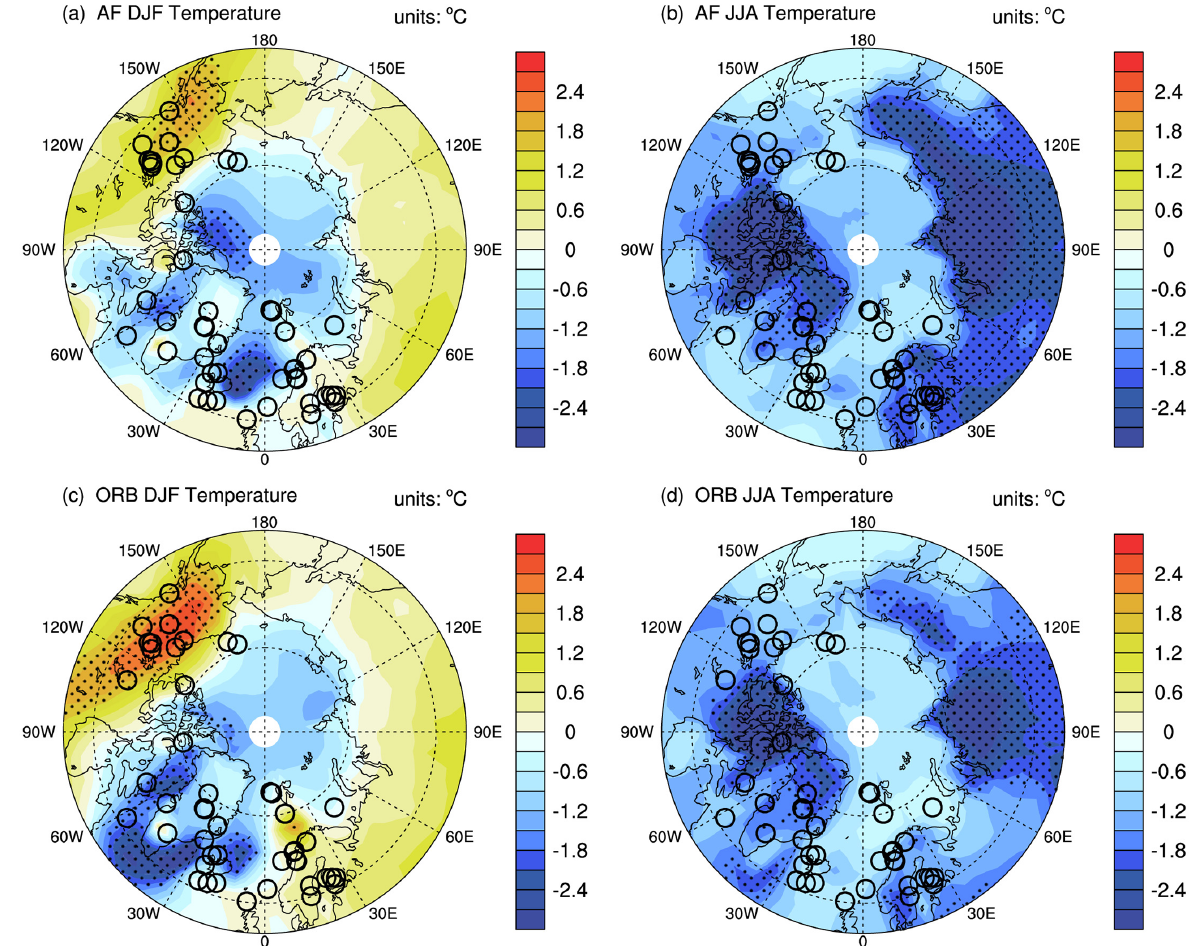
Figure 2. (a) The DJF temperature changes between two periods (0–2ka and 5–8ka) in NNU-Hol All forcing simulations (Pacific Arctic: − 0 . 44; Atlantic Arctic: 1.00; the difference is statistically significant at the 95% confidence level). (b) Same as (a) but for JJA (Pacific Arctic: 3.98; Atlantic Arctic: 3.81). (c) Same as (a) but for NNU-Hol ORB forcing simulations (Pacific Arctic: − 0 . 80; Atlantic Arctic: 1.75; the difference is statistically significant at the 95% confidence level). (d) Same as (c) but for JJA (Pacific Arctic: 7.48; Atlantic Arctic: 6.07). Areas that are dotted are significant at the 90% confidence